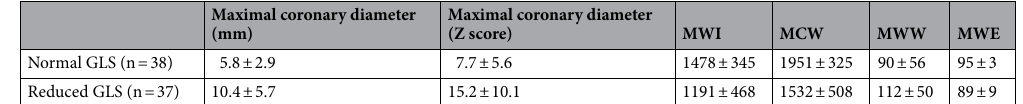
Maximal coronary diameter (Z score) MWI MCW